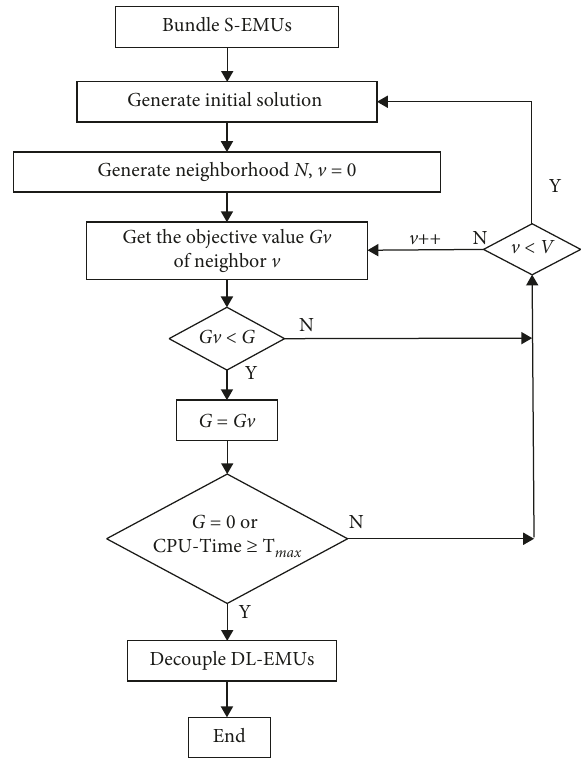
Figure 5: Procedure of the